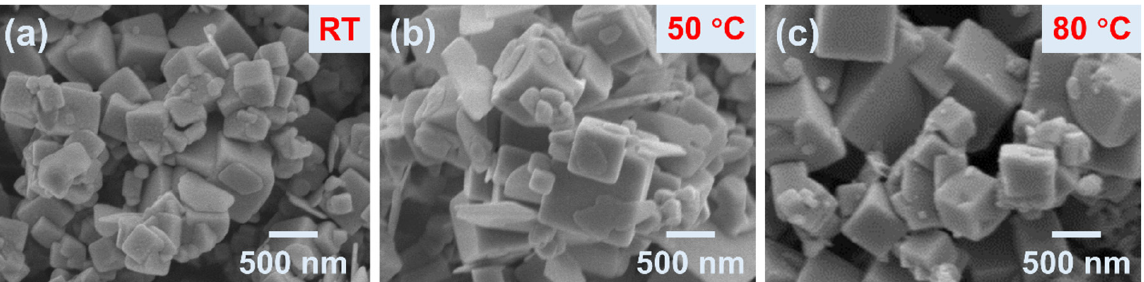
Figure 4. SEM photographs of pure KBF nanocrystals obtained at different synthetic temperatures, ( a ) room temperature; ( b ) T=50 °C; ( c ) T=80 °C.